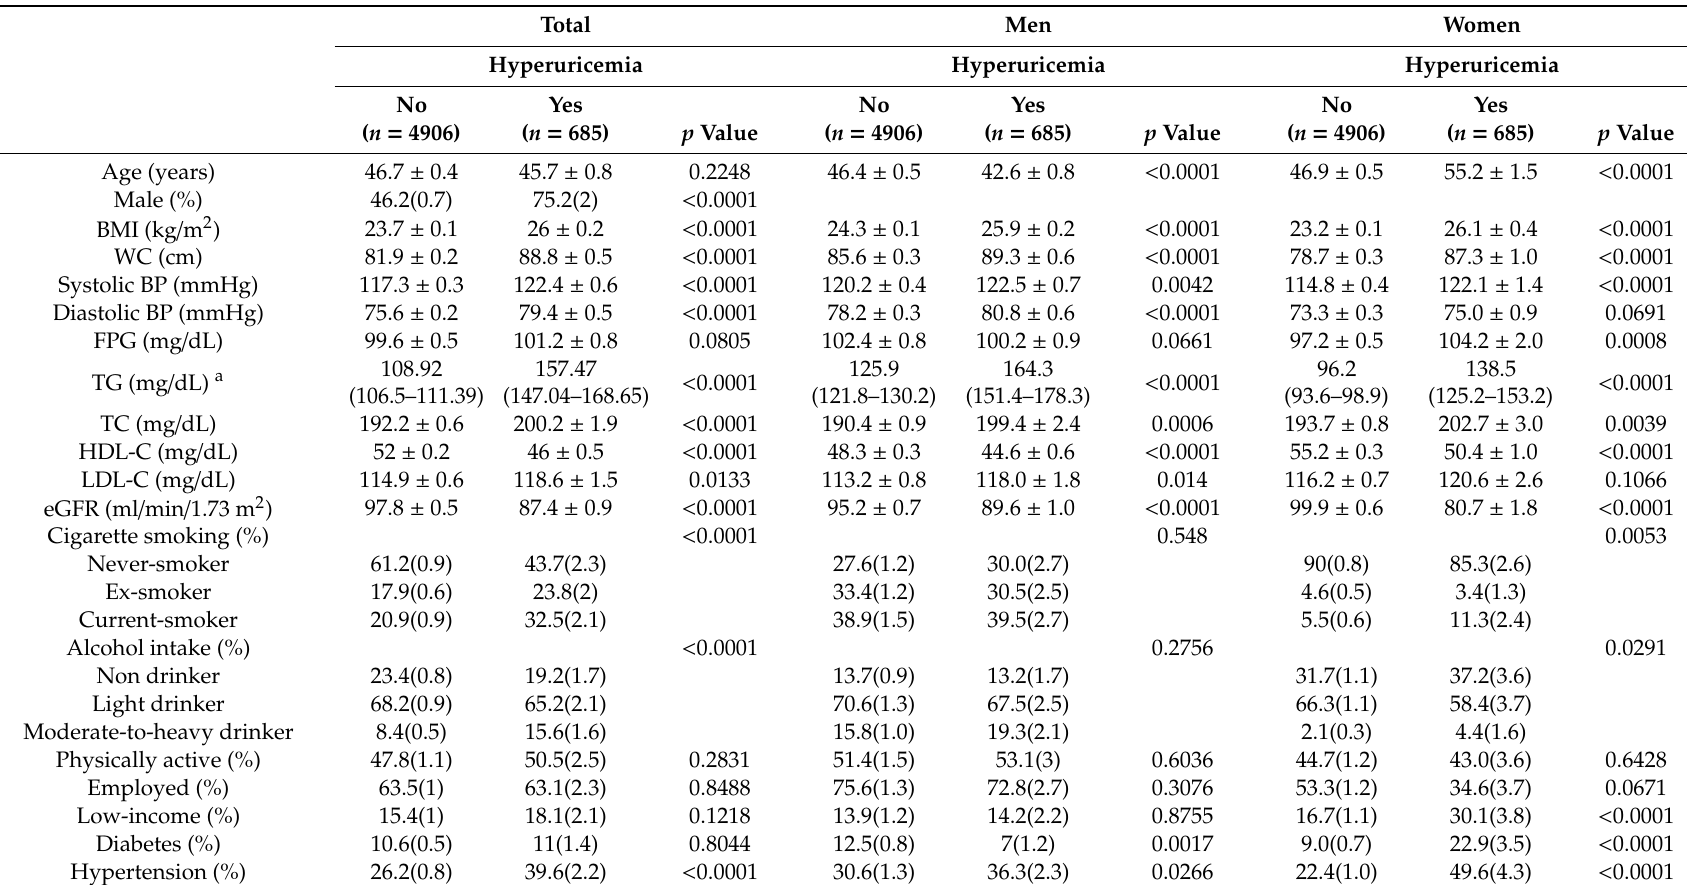
Table 1. Baseline characteristics of study population. A total of 685 individuals were classified as having hyperuricemia among 5591 subjects, based on 2016 Korean National Health and Nutrition Examination Survey